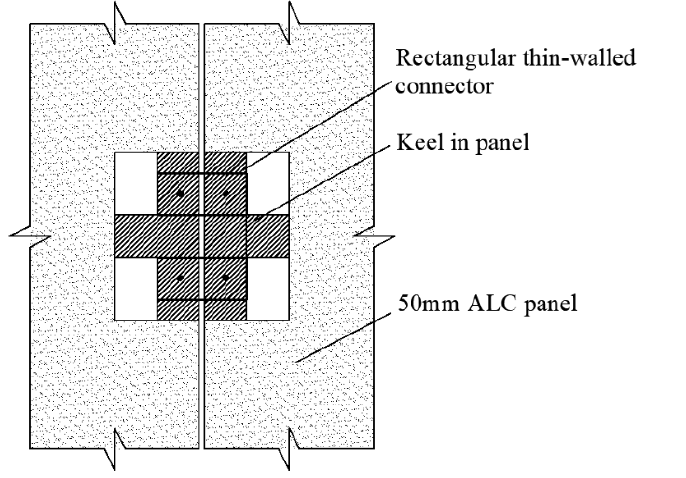
Figure 4. Plan view of the H-shaped steel beam-column covered by the ALC wall panels. As a simple and efficient connection between the wallboard and the beam-column, U-shaped steel sheets were embedded on the sidewall of the beam-column panel to connect the panels with self-tapping screws. Two 5 × 10 cm rectangular openings were cut into the panel, exposing the light steel keel frame to insert the U-shaped thin-wall channel steel, and self-tapping screws were used to connect the components, as shown in Figure 5. After connecting, the opening was filled with ALC panels again.